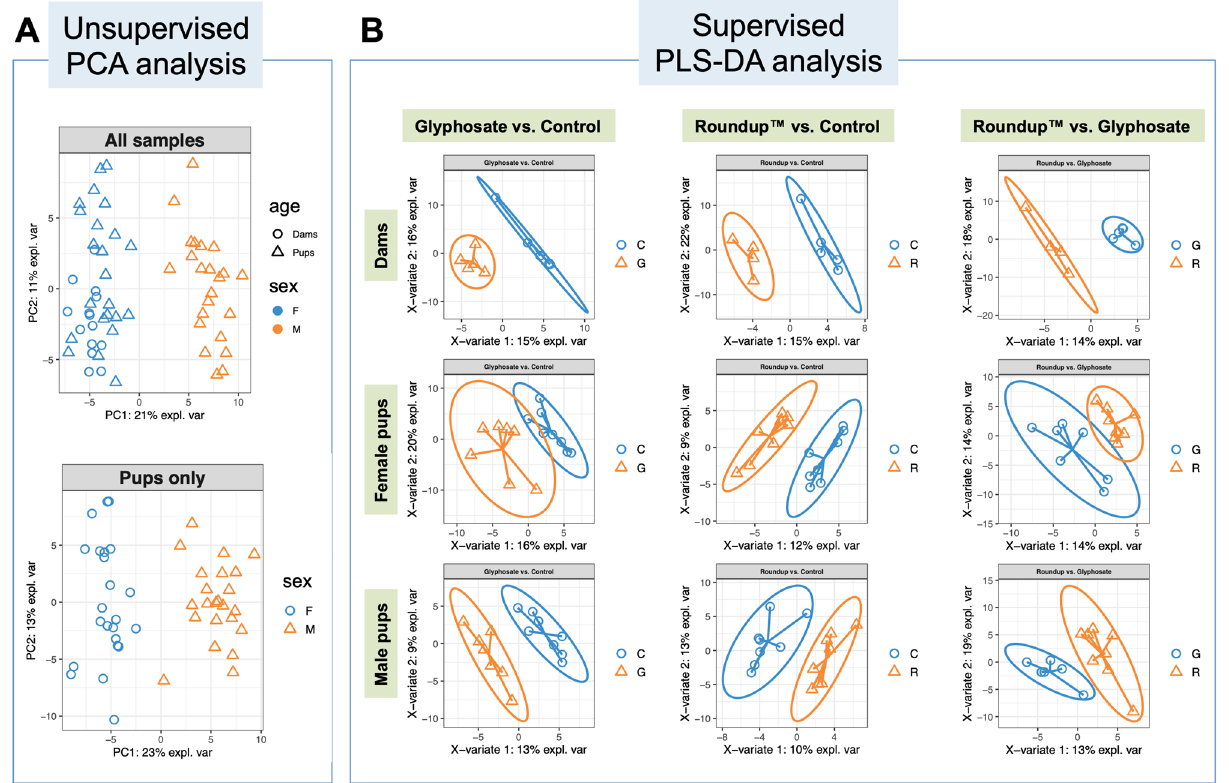
Figure 2. Differential metabolomic profiles by glyphosate exposure in rat female and male pups. ( A ) Unsupervised PCA analysis shows the metabolomic profiles were differentiated by adulthood and sex. ( B ) Supervised Partial Least Squares Discriminant Analysis (PLS-DA) shows distinct metabolome clusters that are strongly associated with the exposure chemicals among groups by adulthood and